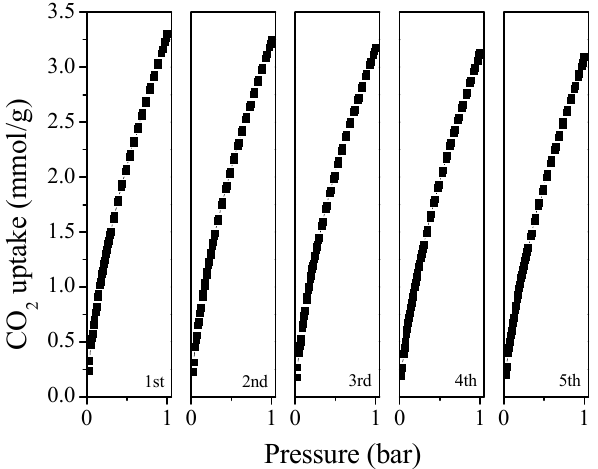
Figure 8. Cyclic study of CO 2 adsorption for MFC-700-0.2.